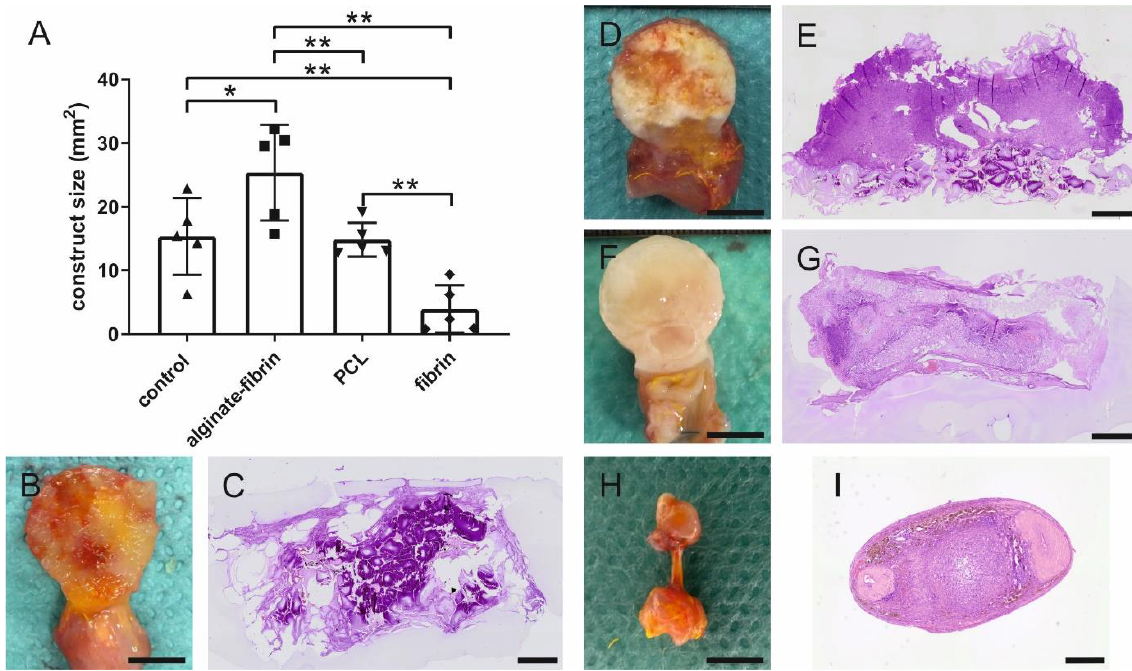
Figure 4. Morphometric analysis of the construct size. ( A ) Quantitative analysis of the construct size of H&E stained cross sections. Representative images of H&E staining of cross sections and macro-scopic pictures of the constructs derived from control ( B , C ), alginate – fibrin ( D , E ), PCL ( F , G ), and fibrin ( H , I ) groups explanted after 8 weeks. Scale bar ( B , D , F , H ): 1 cm, ( C , E , G , I ): 1 mm. * p < 0.05, ** p < 0.01.